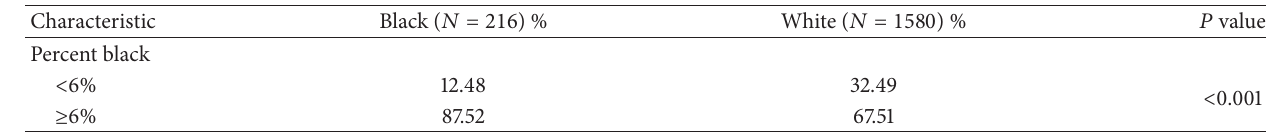
a Personnel and facilities, two measures of health care access were defined using principal components analysis on the count per 10,000 population of county level variables and then categorized into tertiles. Facilities: hospitals, mammography facilities; Personnel: MDs, Dos, and nurse practitioners. b Measures of SES at the county level are the ICE-Income and ICE-Education variables which were calculated and categorized into tertiles, defined as: ICE-Education = ( % 25 + years with college degree − % 25 + years with < 9yrs